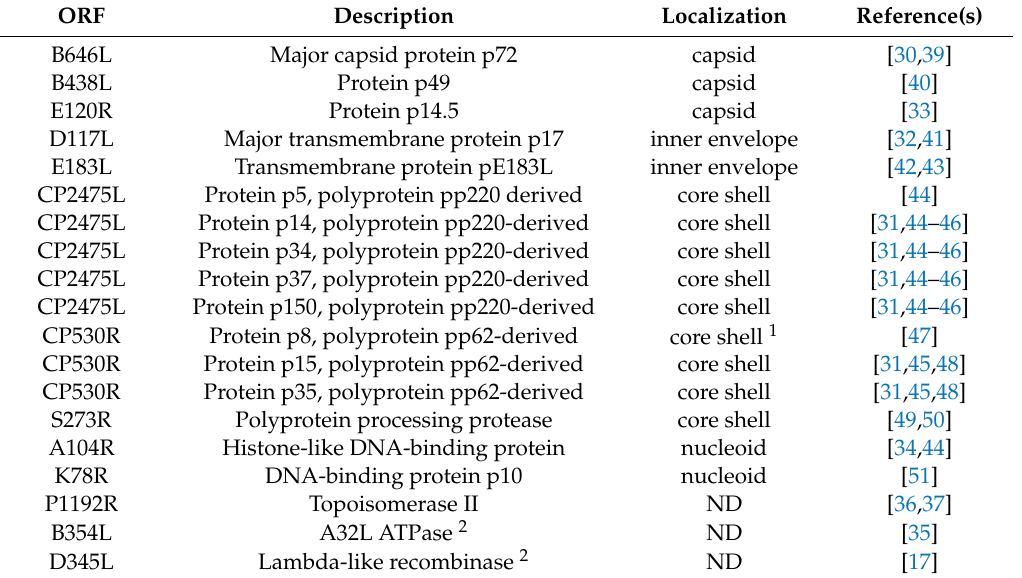
Table 1. African swine fever virus (ASFV) Structural proteins and proteins involved in assembly.